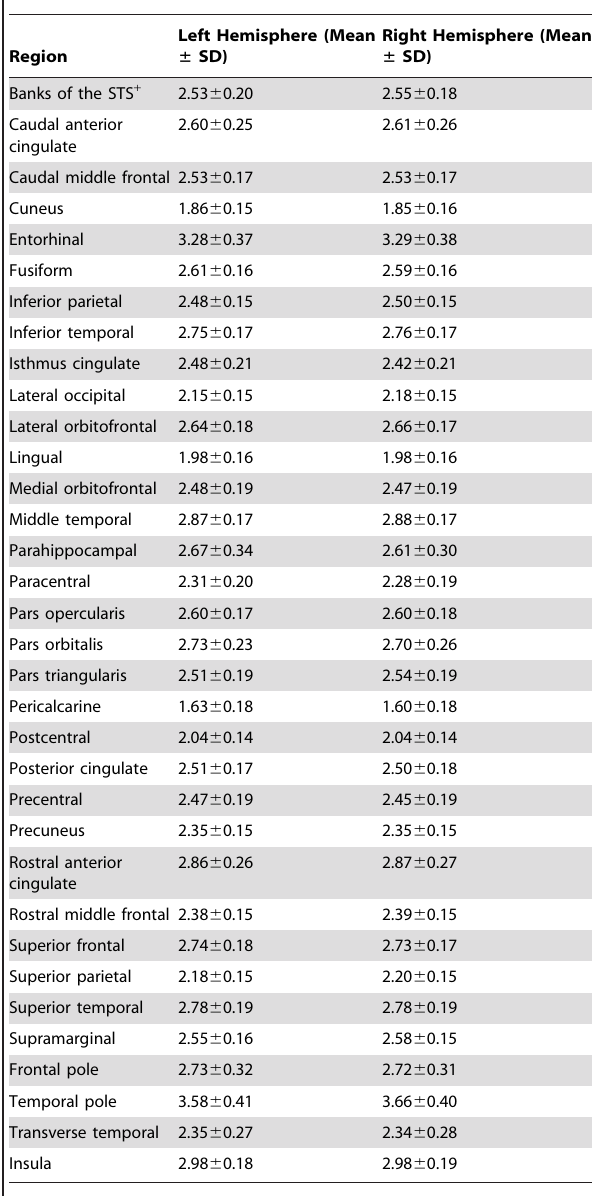
Table 3. Mean Regional Cortical thickness for both hemispheres in 295